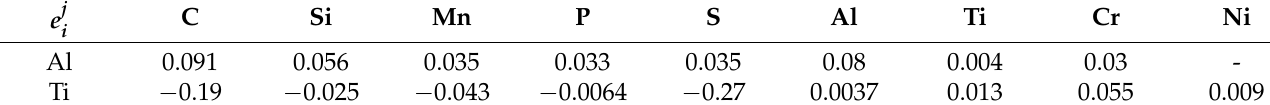
j e of the constituent in the present work. of the constituent in the present work. Table 5. Activity interaction coefficient i i